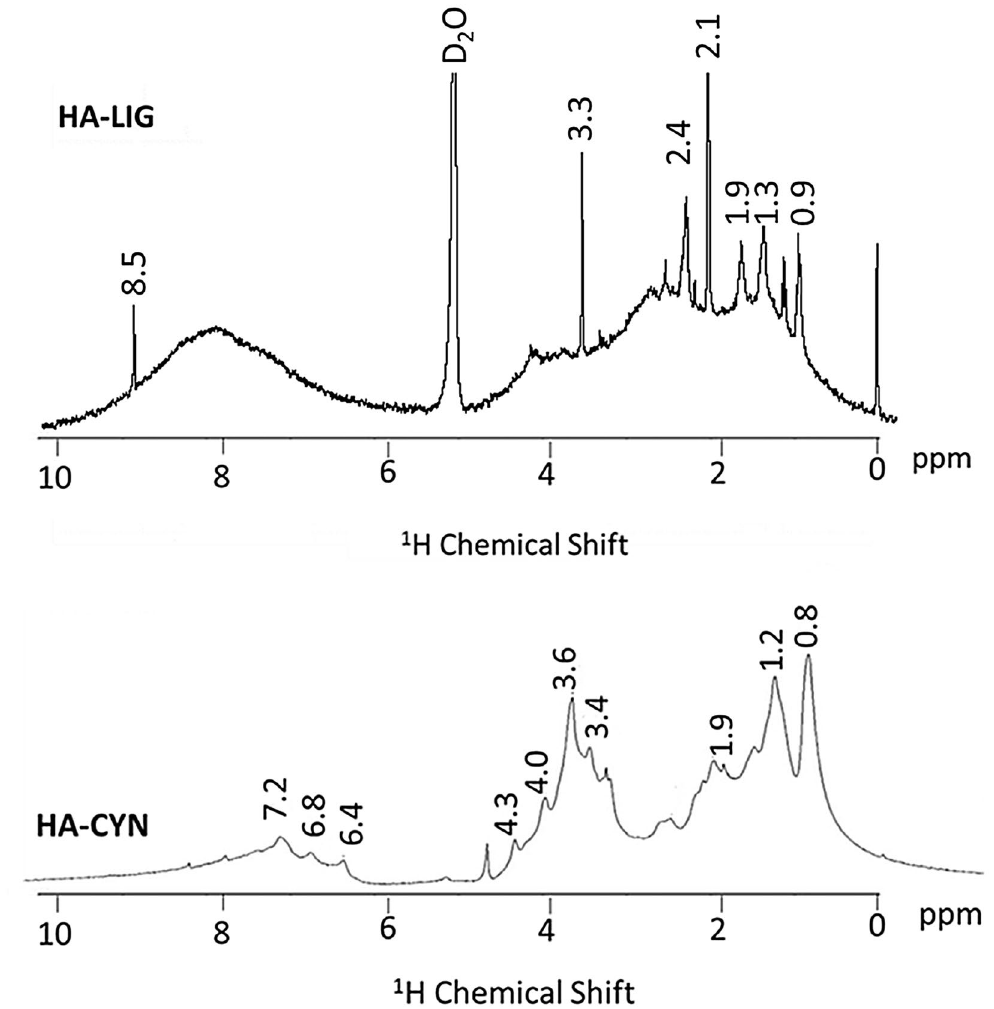
Figure 3. The liquid state 1 H-NMR spectra of HA isolated from lignite (HA-LIG) and green compost made of artichoke residues